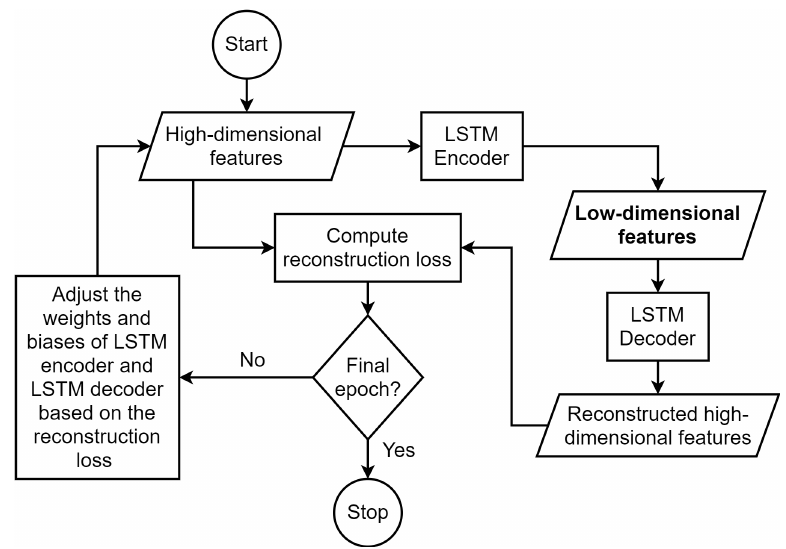
Figure 2. LAE model for feature dimensionality reduction.